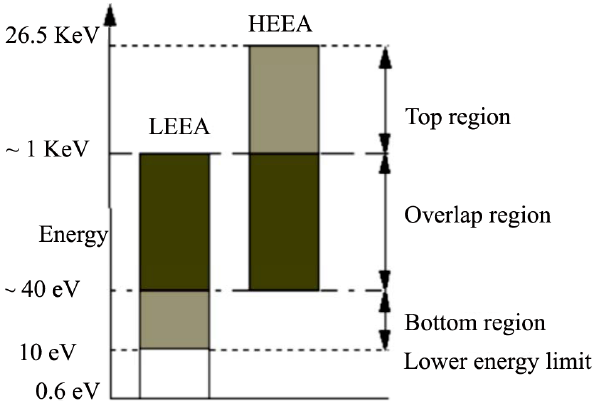
Fig. 2. An example of the energy range coverage for the combina- tion of the two analysers. The moment calculations are calculated from electrons observed with energies of > 10eV, with the bottom region at 10eV–40eV, overlap at 40eV–1keV and the top region at >